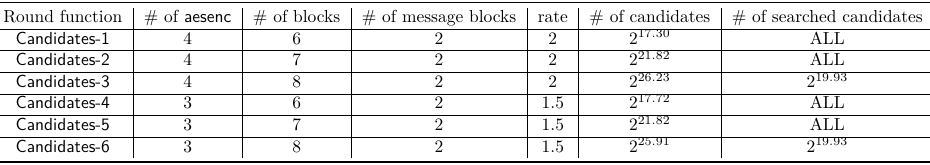
Table 4: Candidates of round functions which we